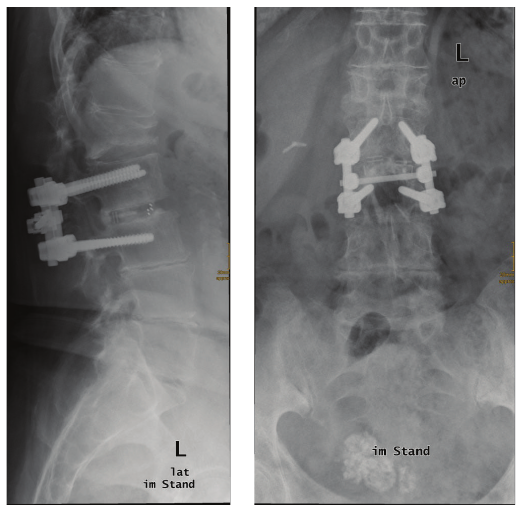
Figure 1: Preoperative X-ray in standing position in sagittal and antero-posterior plane and AP. Fresh fracture in L1. Prior operation was performed in L2/3 with a posterior lumbar intervertebral fusion (PLIF) 2 years ago.